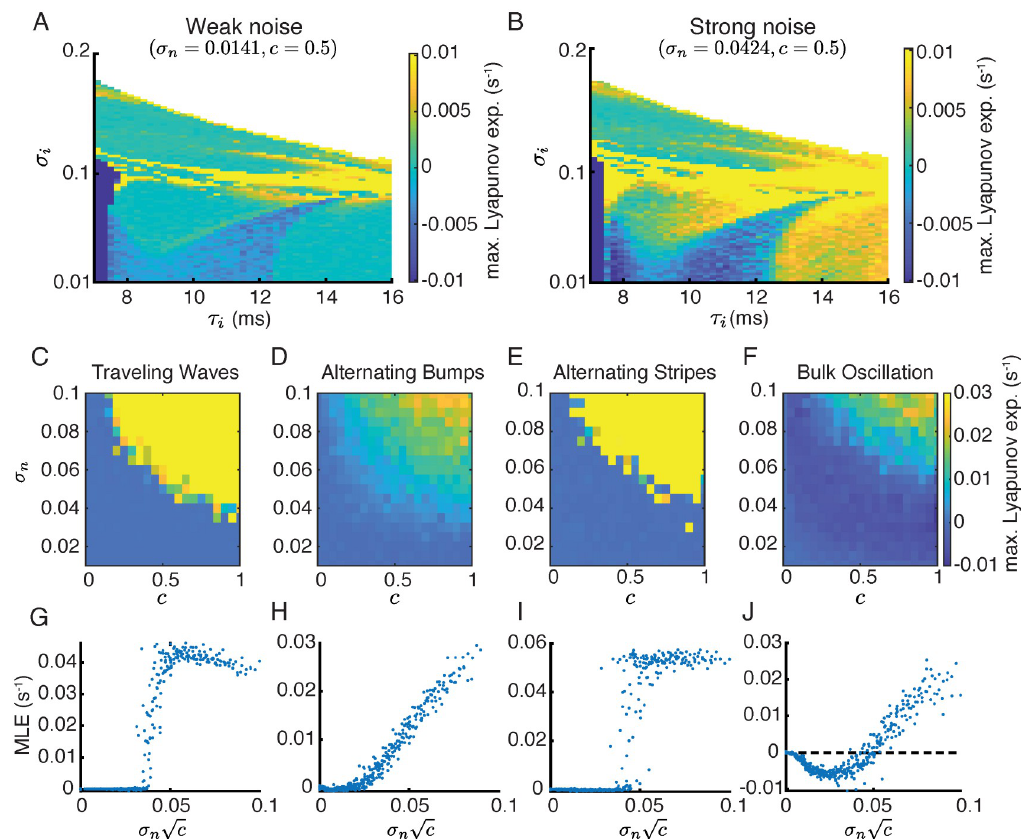
Fig 7. The maximal Lyapunov exponent (MLE) for the two-dimensional networks with input noise. A-B . The MLE map with weak ( A , σ = 0.0141) and strong ( B , σ = 0.0424) noise. The correlation of the input noise is c = 0.5. C-F . MLE as a n n function of the amplitude ( σ n ) and the correlation ( c ) of input noise, for four example networks that generate traveling waves (C; τ i = 8, σ i = 0.1, same as Fig 3A), or alternating bumps (D; τ i = 9, σ i = 0.06, same as Fig 3B), or alternating stripes (E; τ i = 9, σ i = = 8, σ = 0.03) without noise. G-J . Same as panels C-F with MLE as a function of the 0.1, same as Fig 3C) or bulk oscillation (F; τ i i ffiffi p amplitude of the correlated noise component, s c n